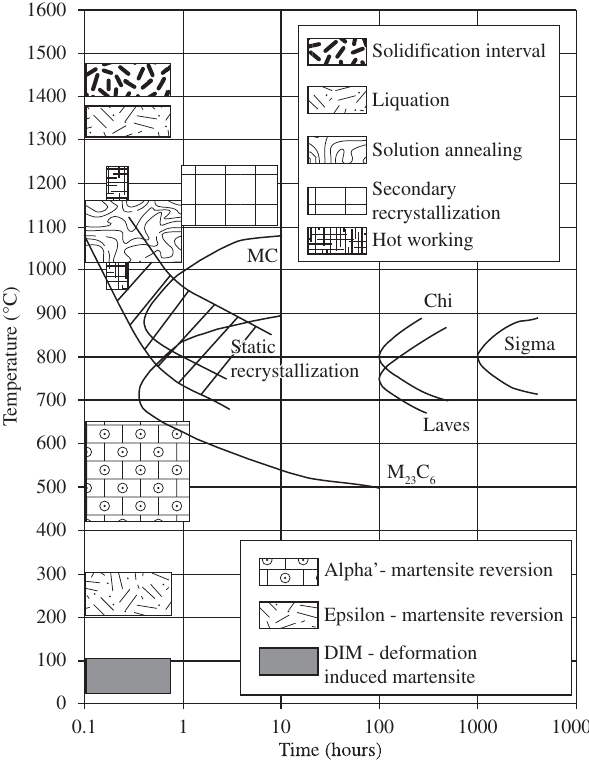
Figure 3. Main transformations that occur in austenitic stainless steels between room temperature and the liquid state 13 .